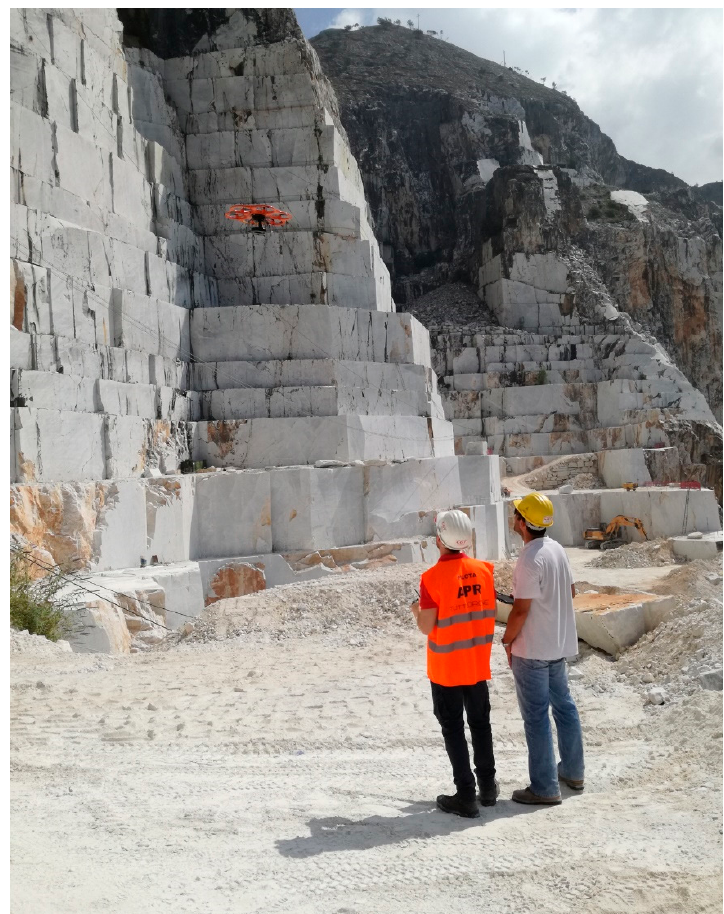
Figure 2. UAV survey at the Lorano marble quarry.